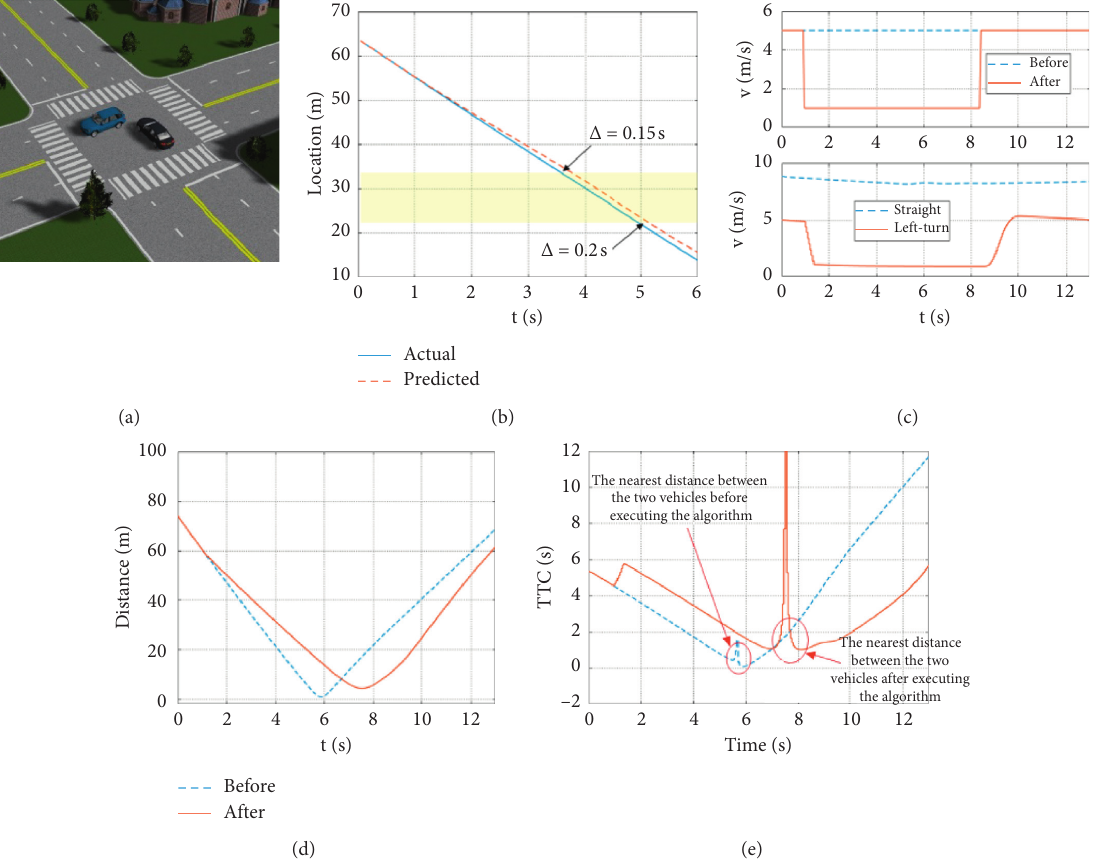
Figure 9: (a) Scenario 1. (b) Predicted trajectory. (c) Velocity. (d) Distance. (e)